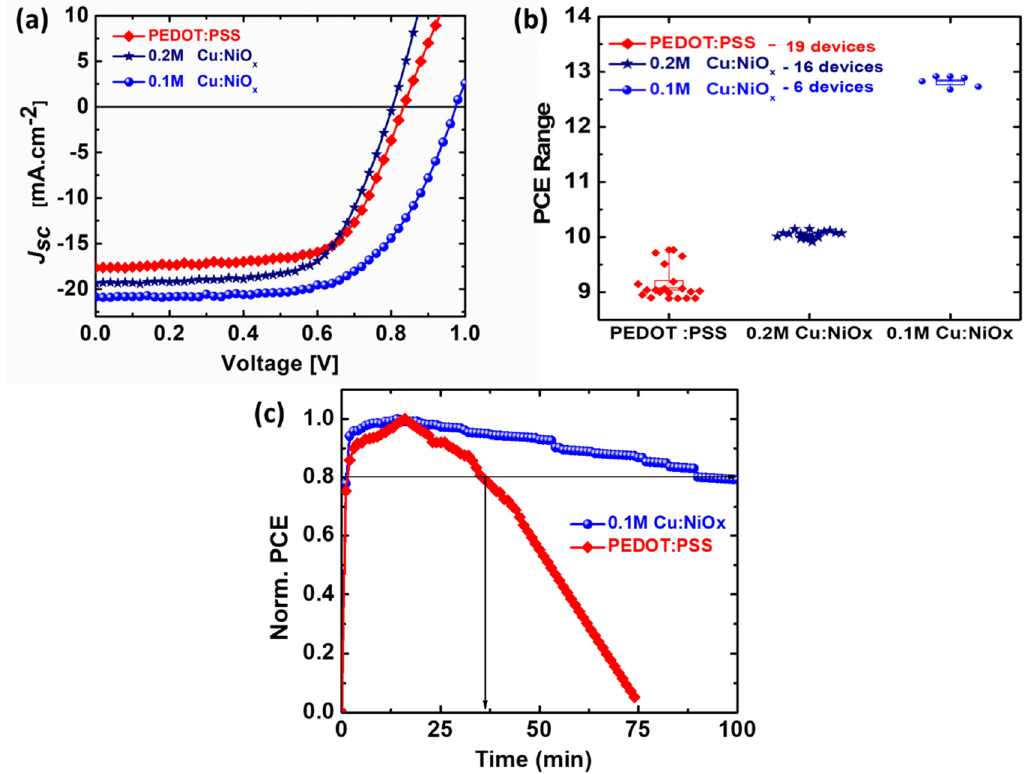
Figure 7. Density–voltage ( J–V ) curve of fabricated devices ( a ); photoconversion efficiency (PCE) count of the three solar cells ( b ); and photodegradation: PCE over time of PEDOT:PSS and 0.1 M Cu:NiO x /PEDOT:PSS-based solar cell ( c ).